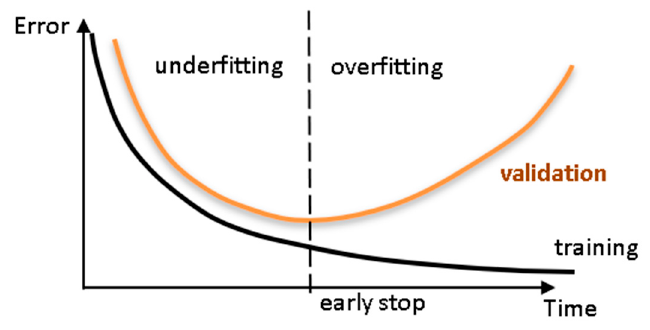
Figure 2. Cross-validation—assessing network’s generalization ability.